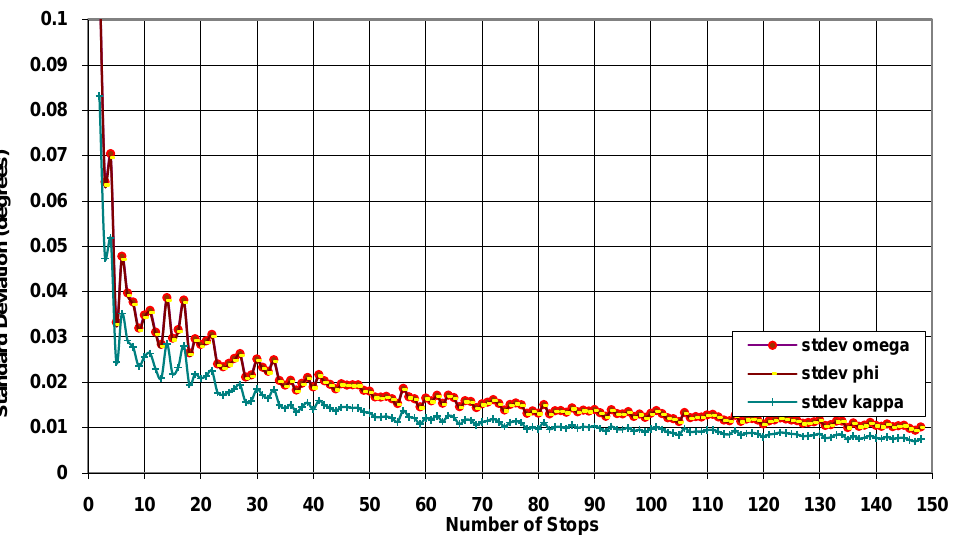
Figure 4. Simulation Results of the Dual-Antenna Case showing precision of calculated orientation angles vs. number of device stops; the curve's actual dampening happens at close to 100 stops; the achieved accuracy is twice as high as what is required for stationary